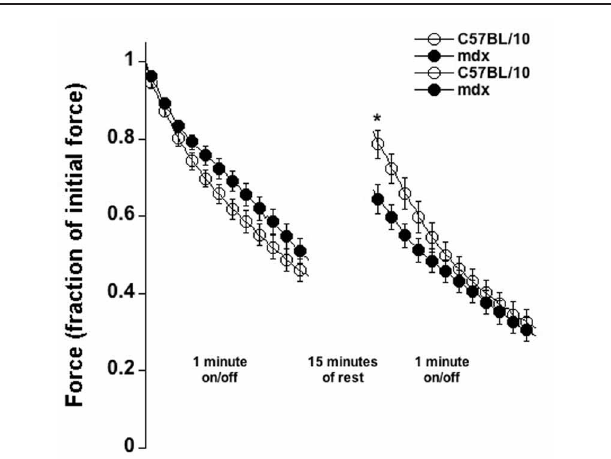
FIGURE 6 | Fatigue/injury-induced by 60 repetitive contractions (each 500ms tetanus followed by 500ms rest), followed by 15min of rest and a repeat in C57BL/01 and mdx muscles at 37 ◦ C. Overall fatigue is similar in both groups, but the recovery of force is 2-fold better in C57BL/10 muscles compared to mdx muscles ( P < 0 .